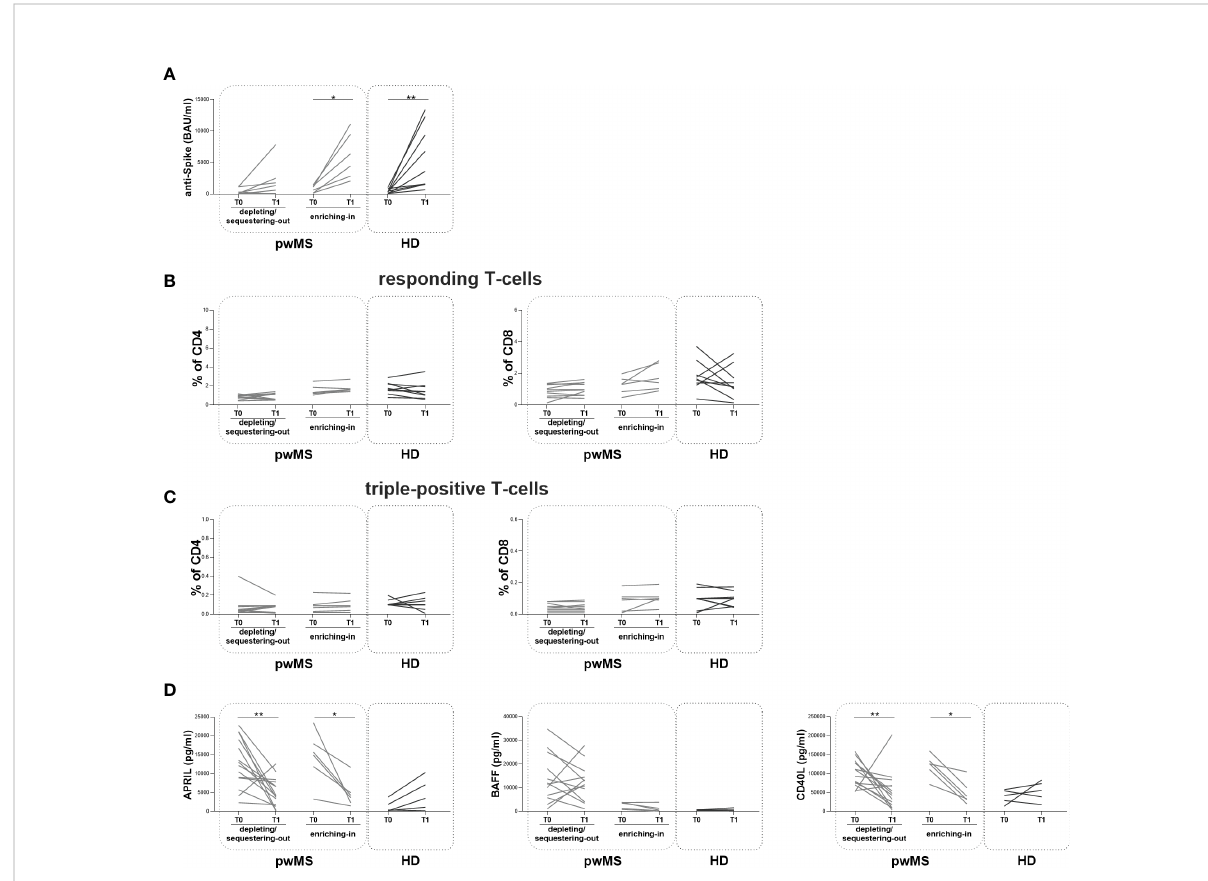
FIGURE 5 Longitudinal evaluation of humoral and speci fi c T-cell response pwMS subgroups and HD. (A) The longitudinal evaluation of anti-S antibody titers between T0 and T1 in the depleting/sequestering-out and in the enriching-in subgroups compared to HD. (B) The evaluation of responding CD4+ and CD8+ T-cells in pwMS subgroups. (C) The evaluation of triple-positive CD4+ and CD8+ T-cells in the depleting/sequestering-out and in the enriching-in subgroups. (D) The longitudinal evaluation of plasma levels APRIL, BAFF and CD40L. APRIL, A-proliferation inducing ligand; BAFF, B-cell activating factor; CD40L, CD40 ligand; pwMS, people with multiple sclerosis; HD, healthy donors; T0, before third dose of vaccine; T1, after two months from third dose of vaccine. *p < 0.05; **p <